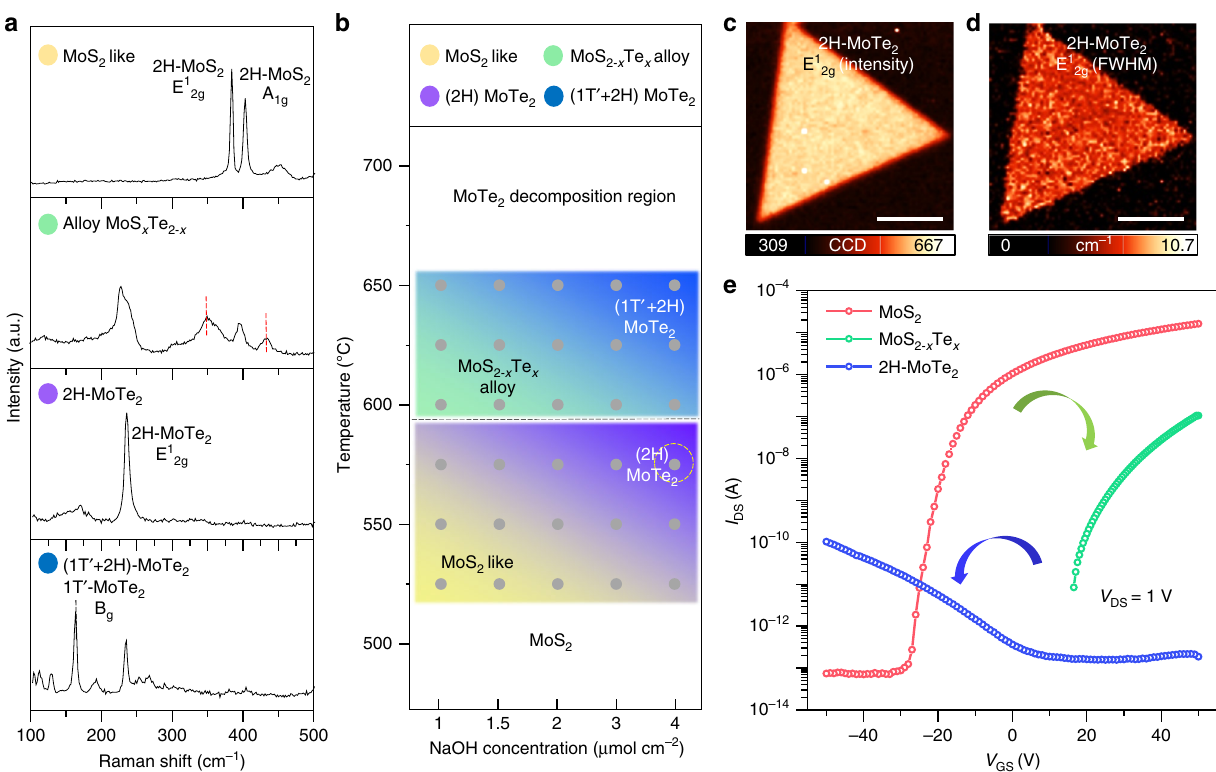
Fig. 5 Phase modulation with NaOH concentration and temperature. a Raman spectra of representative MoS 2 − x Te x phases with an excitation wavelength of 532 nm. b Phase modulation of MoS 2 − x Te x identi fi ed from Raman spectra and optical images. c , d Confocal Raman mapping images for the intensity ( c ) and FWHM ( d ) of fully converted 2H-MoTe 2 ; scale bars, 10 μ m. e Electrical transport characteristics of pristine MoS 2 , MoS 2 − x Te x , and 2H-MoTe 2 . The threshold voltage in the MoS x Te 2 − x alloy (red) is shifted positively from pristine MoS 2 (green). The p-type behavior is shown